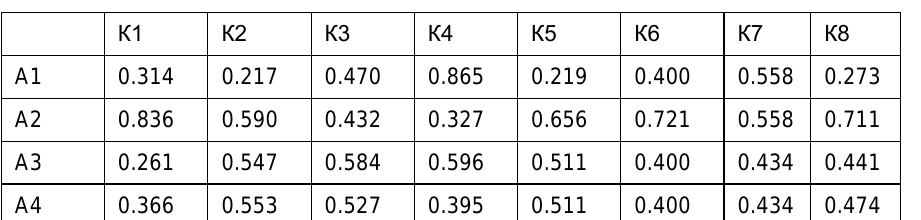
Table 4 – Normalized decision